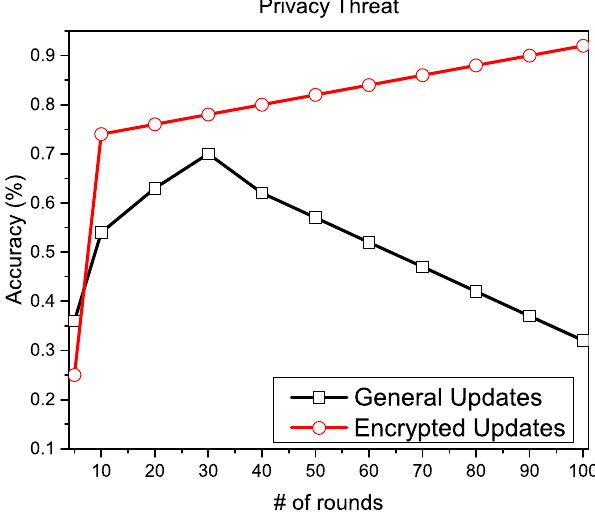
Figure 4. Convergence with and without